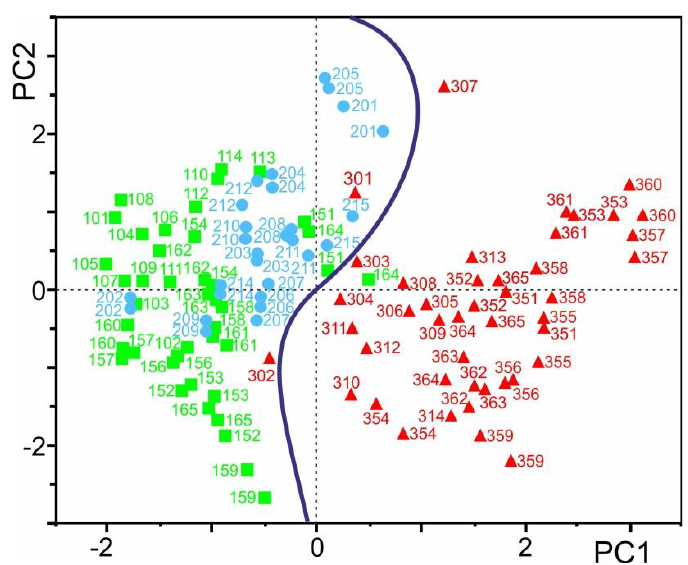
Figure 5. Principle component analysis with quotient values A, B, and C of protein ion signal areas of the “validation” test set. This set contains measurement series MS2 of cohorts CTRL I and FGR I plus measurement series MS3 and MS4 of cohorts CTRL II and FGR II, in addition to measurement series MS1 and MS2 of cohort SGA I serum samples ( n = 114) which represent 71 individuals. Locations of mass spectra derived positioning from FGR samples are shown as red triangles, locations of CTRL samples as green squares, and SGA patients as blue circles (filled symbols). The curved line indicates the decision boundary obtained from the support vector machine (SVM) algorithm classifier.